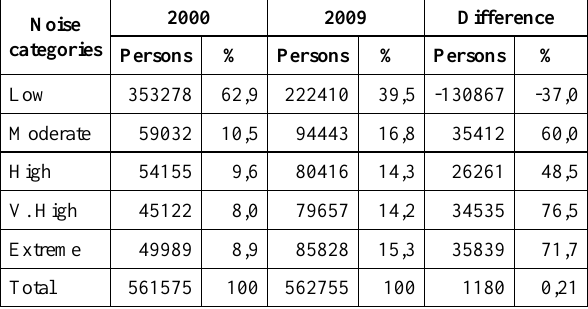
Table 7. Nighttime population exposure to noise in Lisbon in